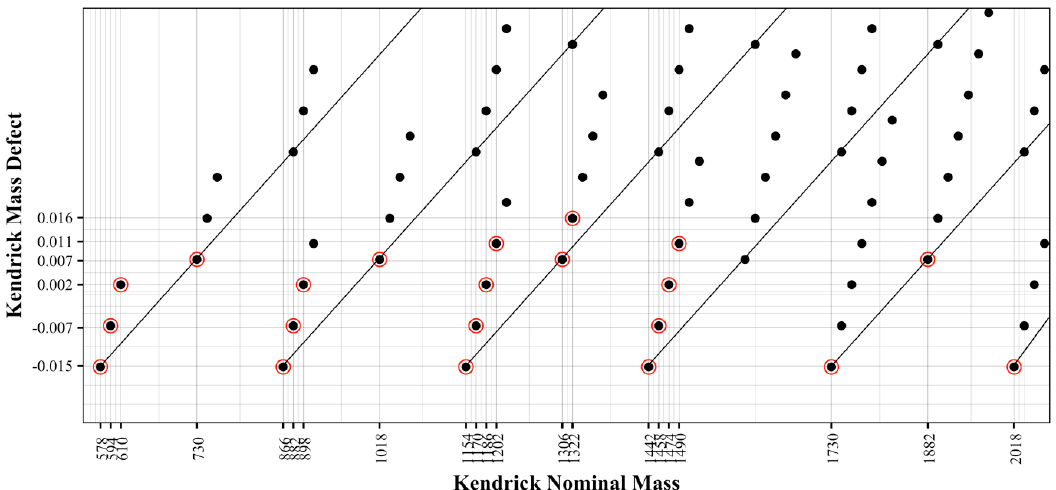
Figure 5. Kendrick defect analysis, created by plotting the Kendrick mass defect (KMD) and Kendrick nominal mass (KNM). Each solid black point represents the KNM and KMD of the proanthocyanidin calculated in the theoretical database. Compounds which were identified in the wine samples are encircled in red.